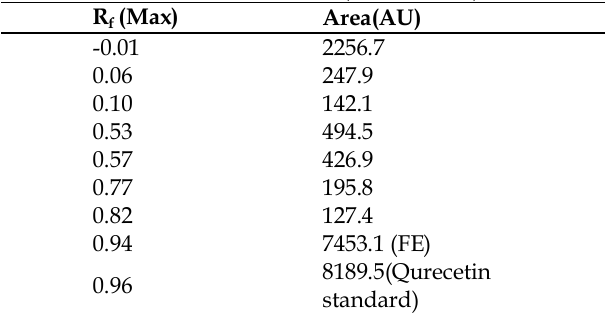
Table 9: R f value and peak area of Fruit extract and standard qurecetin in Ethylacetate: Dichloromethane: Formic acid : Acetic acid : Water (10:2.5:1:1:0.5) at 366 nm.